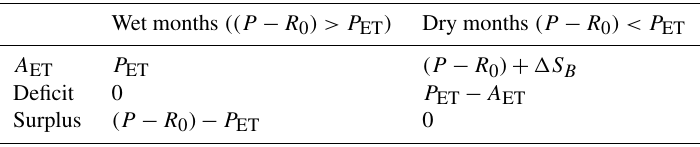
Table 1. Calculations of water balance components (Thornthwaite and Mather,